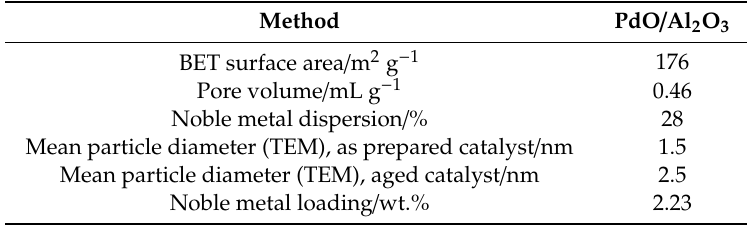
Table 1. Results of the catalyst characterizations obtained from N 2 -physisorption, chemisorption, transmission electron microscopy (TEM) and elemental analysis.